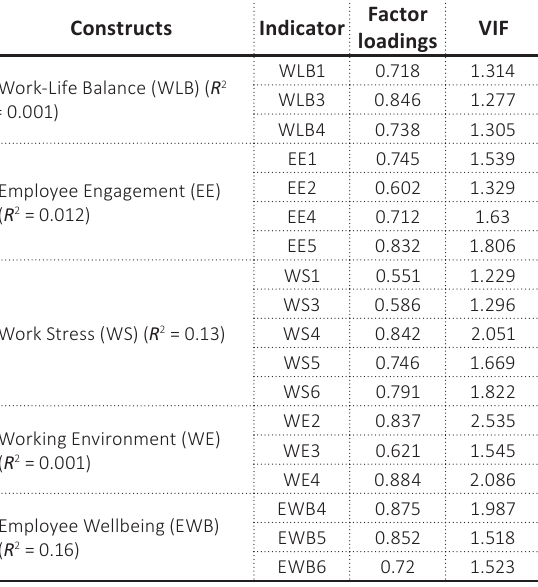
Table 2. Construct reliability and validity